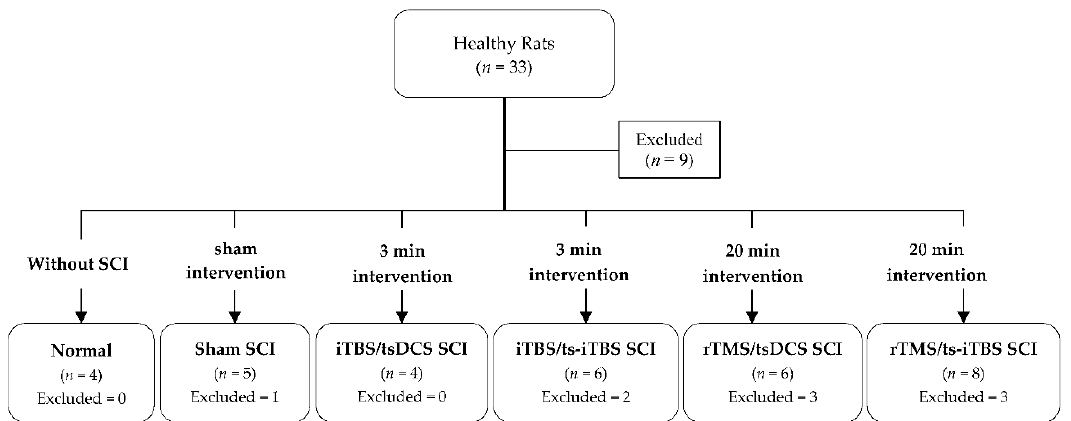
Figure 10. Animal recruitment and grouping for stimulation; SCI, spinal cord injury; iTBS, inter- mittent theta burst stimulation; tsDCS, transspinal direct current stimulation; ts-iTBS, transspinal intermittent theta burst stimulation; rTMS, repetitive transcranial magnetic stimulation.